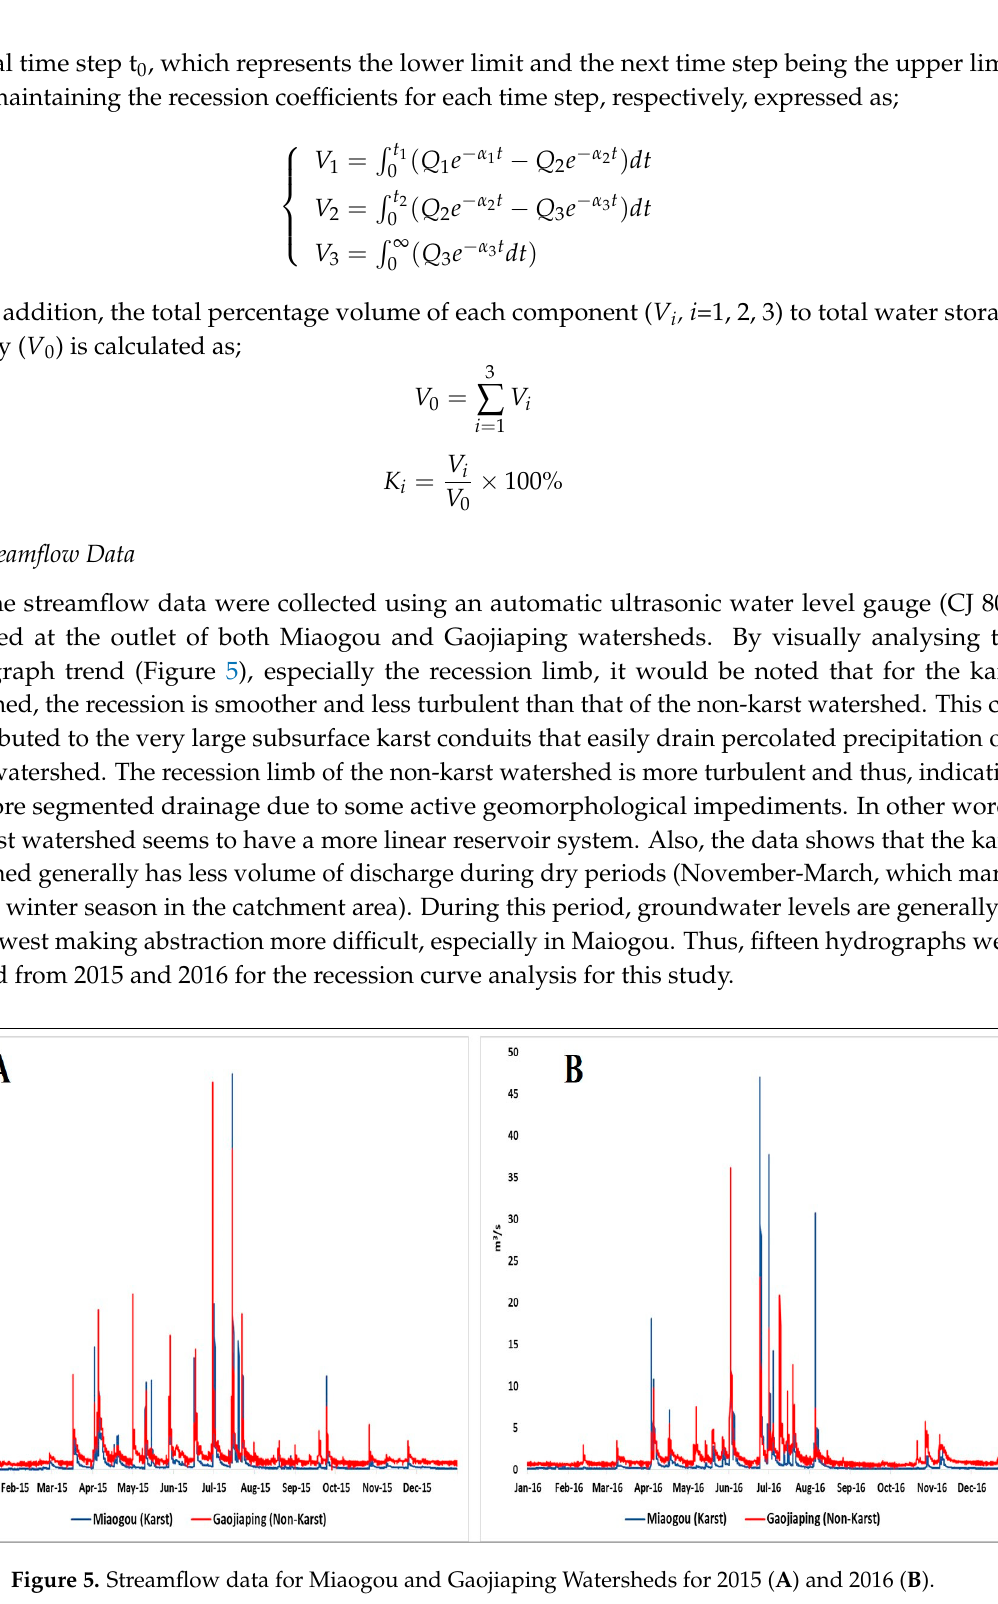
Figure 5. Streamflow data for Miaogou and Gaojiaping Watersheds for 2015 ( A ) and 2016 ( B ).